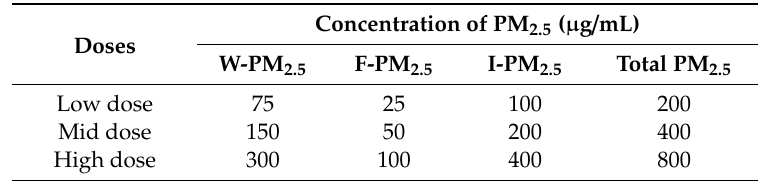
Table 1. Concentration of di ff erent components of PM 2.5